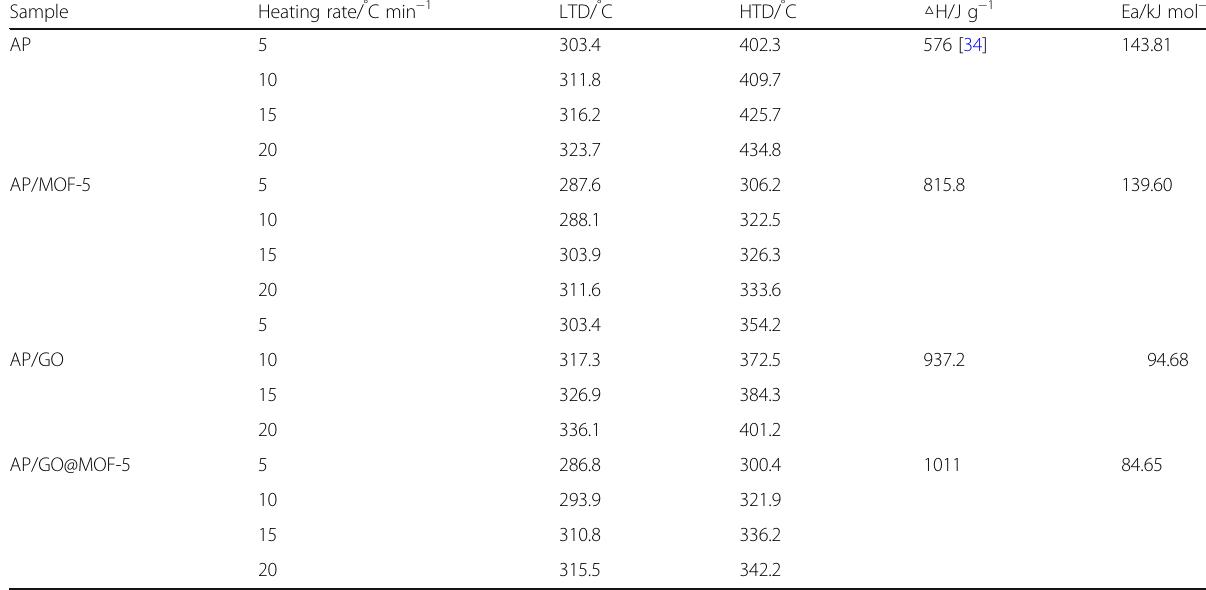
Table 2 Thermodynamic parameters of samples at different heating rates Sample